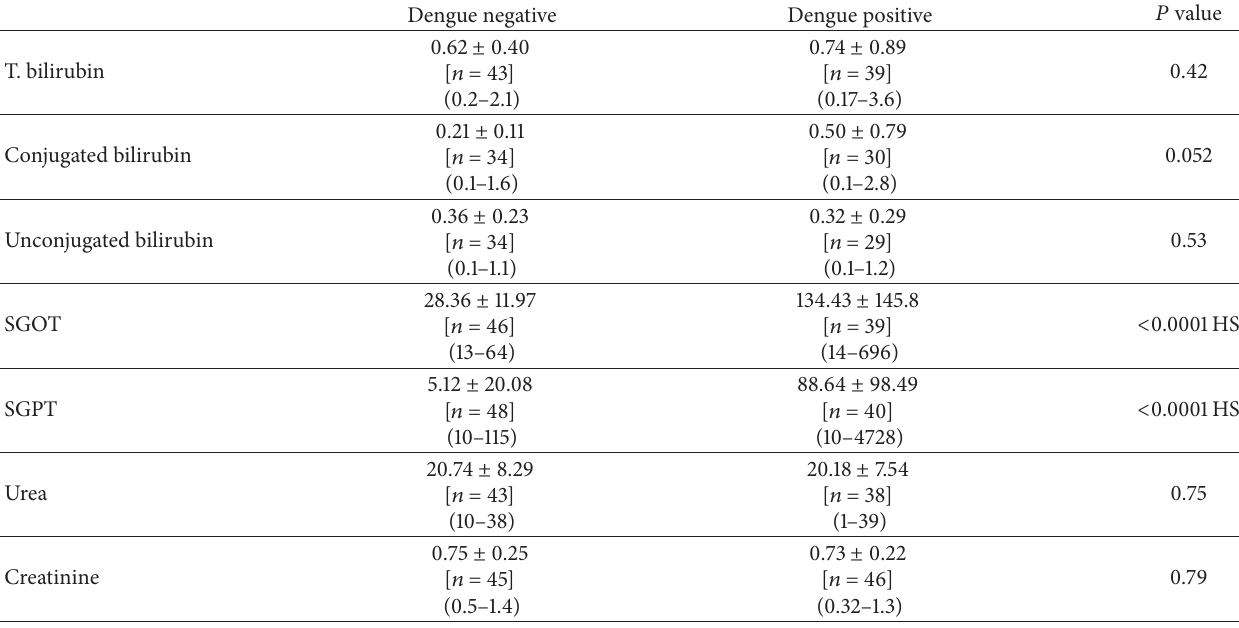
Table 4: Alterations in the biochemical parameters of liver and kidney functioning in the dengue-positive and dengue-negative cases in children.